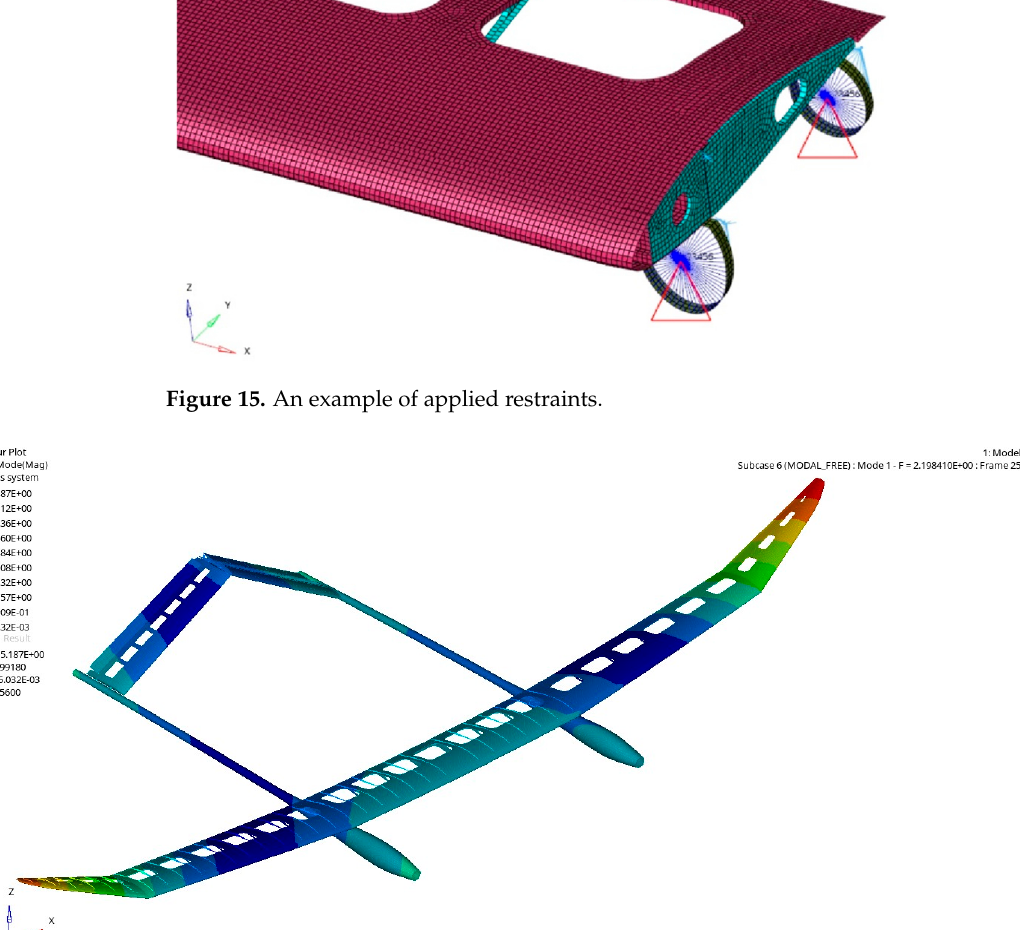
Figure 16. The first calculated natural frequency.